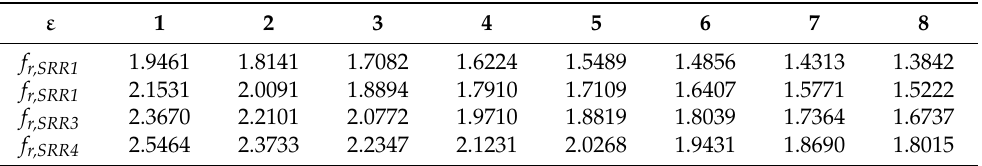
Figure 3. Relationship between the SRR1 resonance frequency and the permittivity of the surrounding material. Table 2. Resonance frequency of the four split ring resonators embedded in a material with permittivity ε .